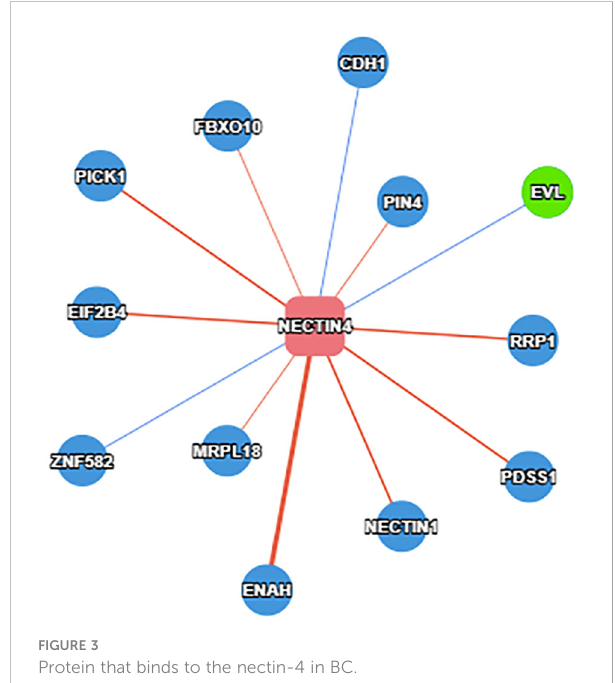
FIGURE 3 Protein that binds to the nectin-4 in BC.